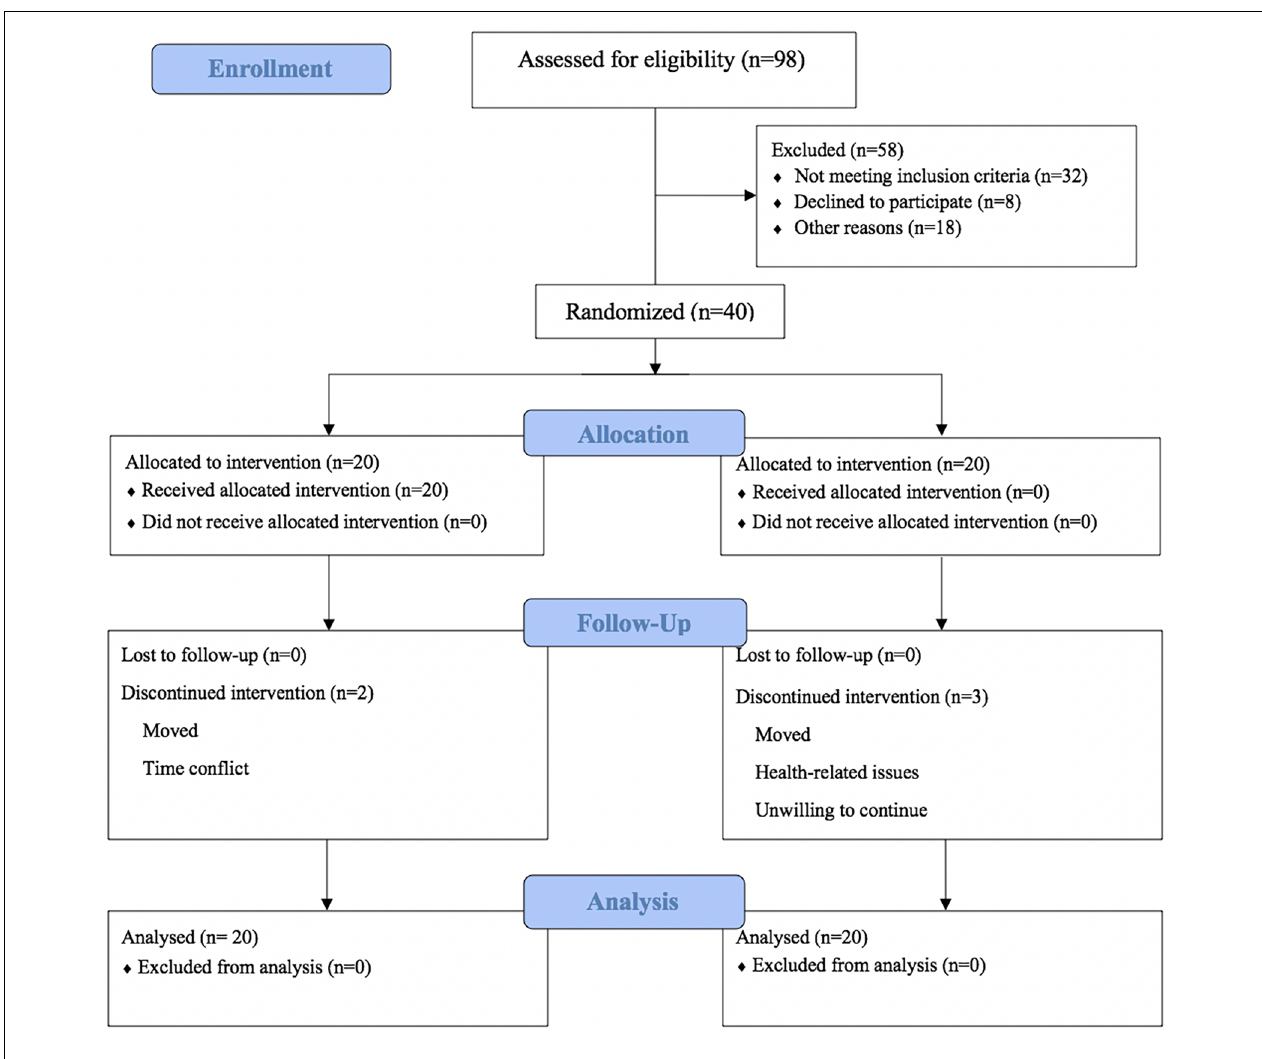
FIGURE 1 | Study flow